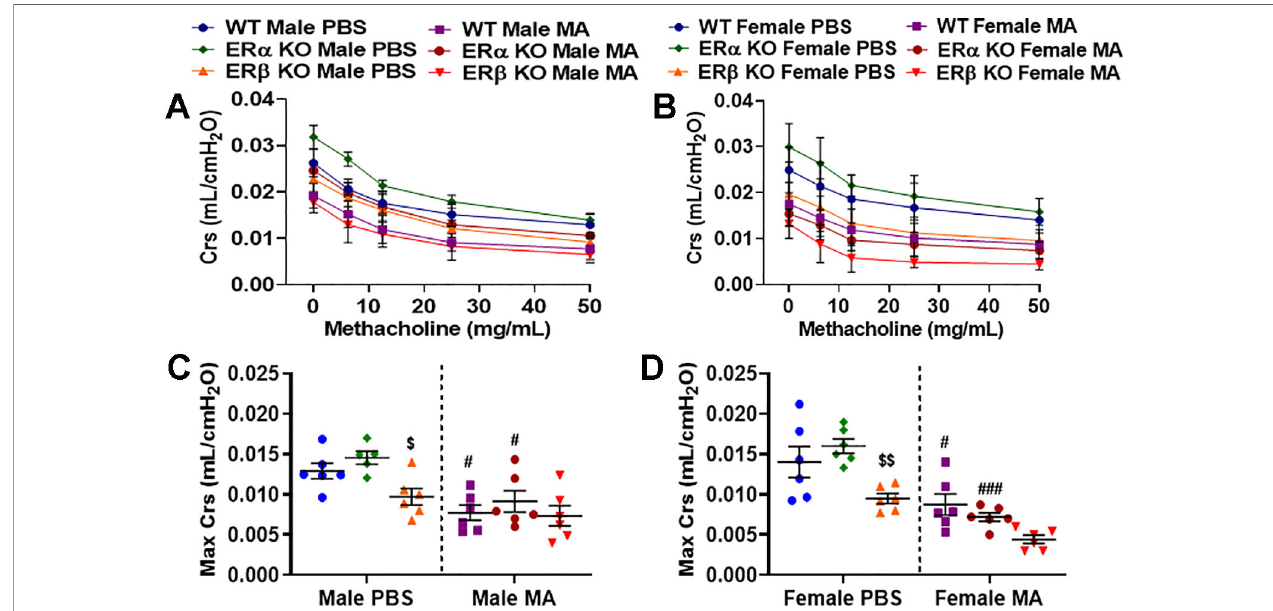
FIGURE 3 | Effect of ER signaling on compliance (Crs) in the lungs of (A) male and (B) female mice (WT vs. ER a KO vs. ER b KO) exposed to PBS and MA. Max Crs was used to compare WT, ER a KO and ER b KO in (C) male and (D) female mice exposed to PBS and MA. Data represented as mean ± SEM of at least 5-6 mice per treatment group; # p < 0.05, ### p < 0.001 vs. PBS of respective groups (MA effect) and $ p < 0.05, $$ p < 0.01 vs. ER a KO of PBS/MA (ER b vs. ER a effect).